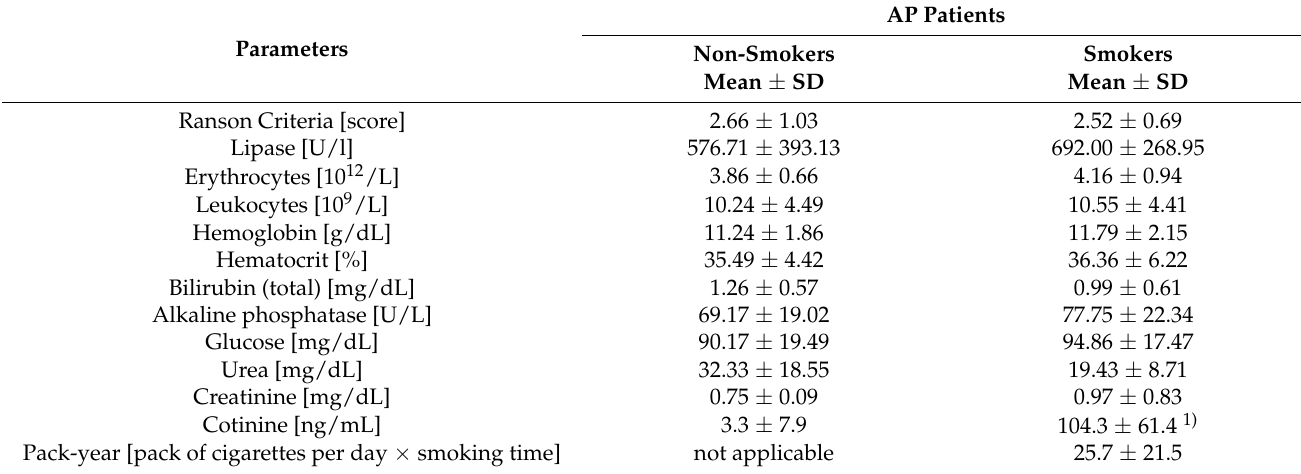
Table 9. Clinical characteristics of the participants in the